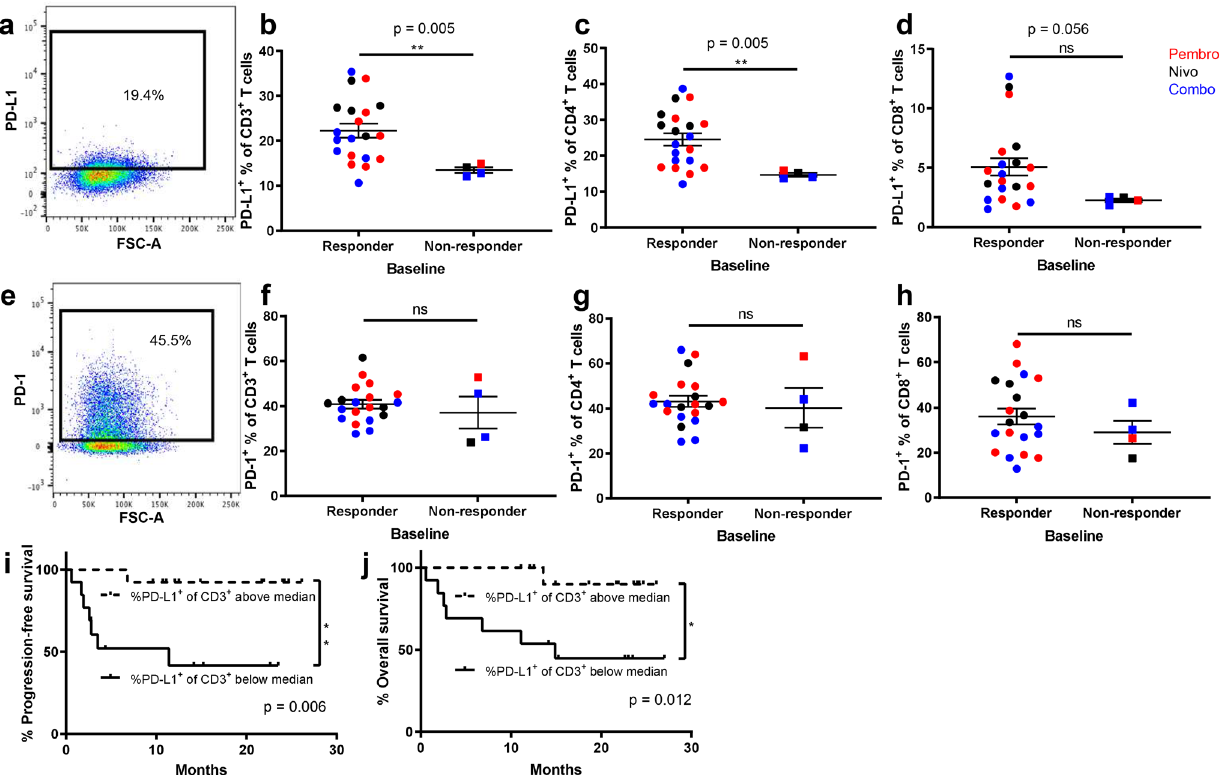
Figure 2. Patients with a higher baseline PD-L1 expression on T cells have a more favourable overall best response. PBMC collected from patients were assessed for PD-L1 and PD-1 expression in the total CD3 + , CD3 + CD4 + and CD3 + CD8 + lymphocyte populations by flow cytometry, using fluorescence-minus one controls to set gates. Frequencies of PD-L1 ( a–d ) and PD-1 ( e–h ) in each population for total responder (n = 20) and non-responder patients (n = 4) were compared using a Mann–Whitney test; **p ≤ 0.005; error bars, SEM. Data is displayed with treatment groups colour-coded; pembrolizumab, red; nivolumab, black; combination nivolumab/ ipilimumab, blue. Kaplan–Meier plot showing progression-free survival ( i ) and overall survival ( j ) of patients with CD3 + T cell %PD-L1 expression above and below the median, p values calculated using Mantel-Cox Log- rank test. See also Supplementary Fig.